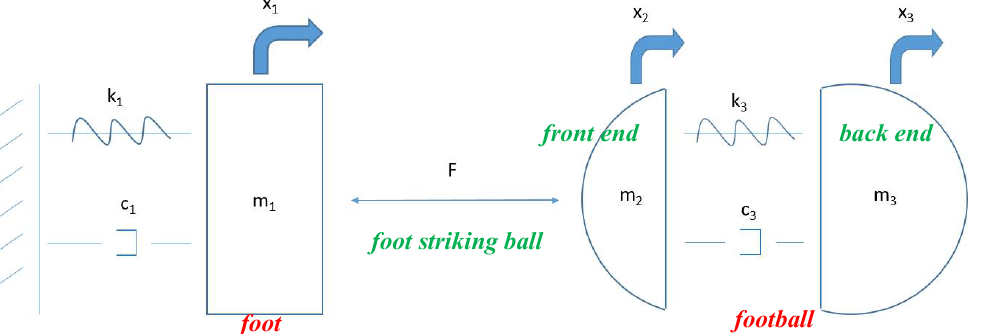
Figure 1. Proposed lumped mass representation of a foot striking a soccer ball with linear stiffness and viscous